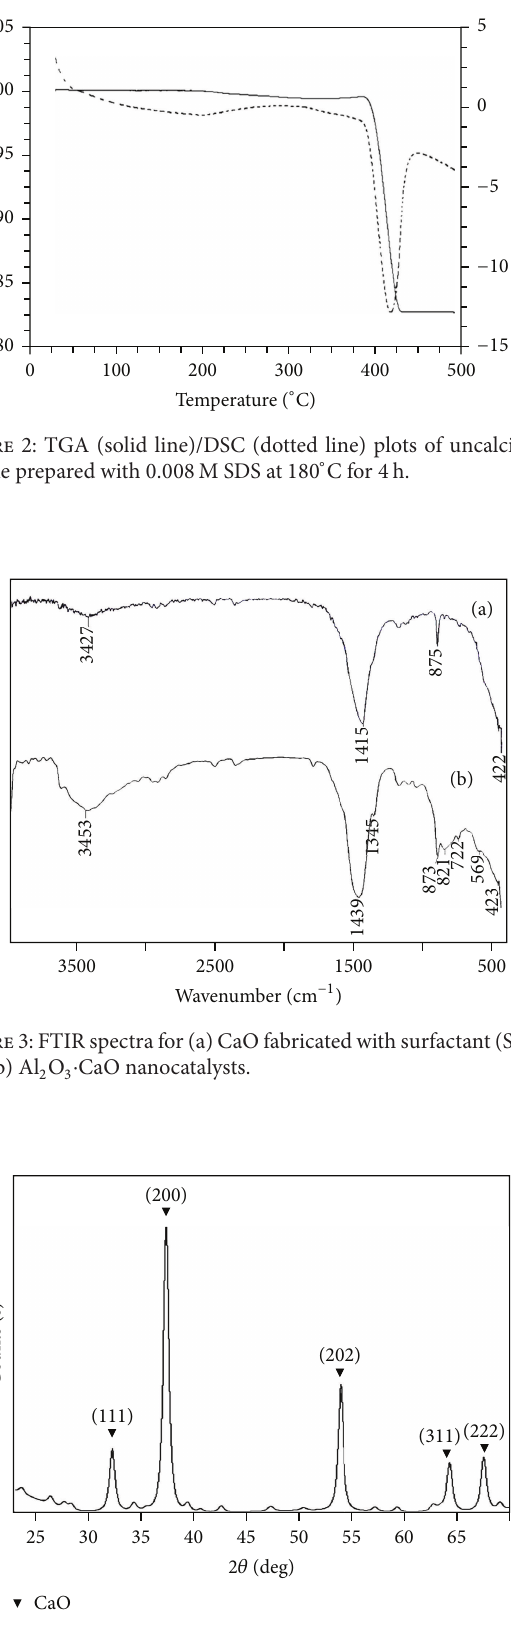
Figure 4: XRD pattern of CaO nanocatalyst fabricated with surfac-